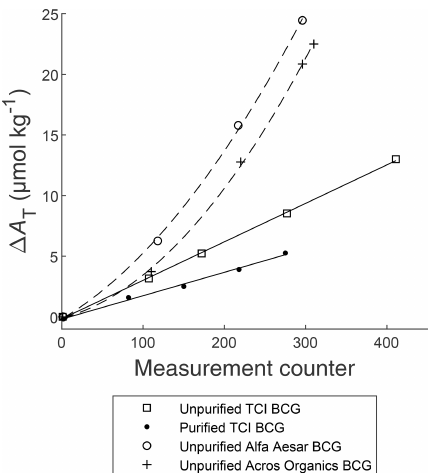
Figure 4. Bias ( (cid:49)A T ) between measured A T and reference value of the CRM as a function of the measurement counter of the CON- TROS HydroFIA ® TA analyzer, where filled circles, open squares, crosses, and open circles represent the average of five repeated mea- surements made with purified BCG (TCI), unpurified TCI BCG, unpurified Acros Organics BCG, and unpurified Alfa Aesar BCG, respectively. The solid lines are the linear regressions of the asso- ciated measurement points. The dashed lines represent a nonlinear